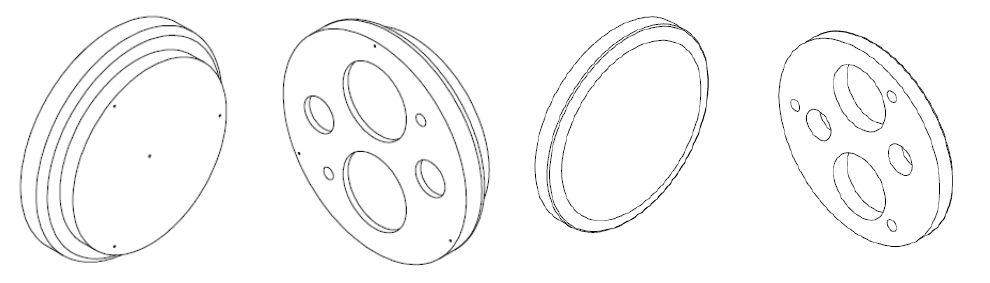
Figure 8. Example of a CAD model of a flange with collar ( left ) and no collar ( right